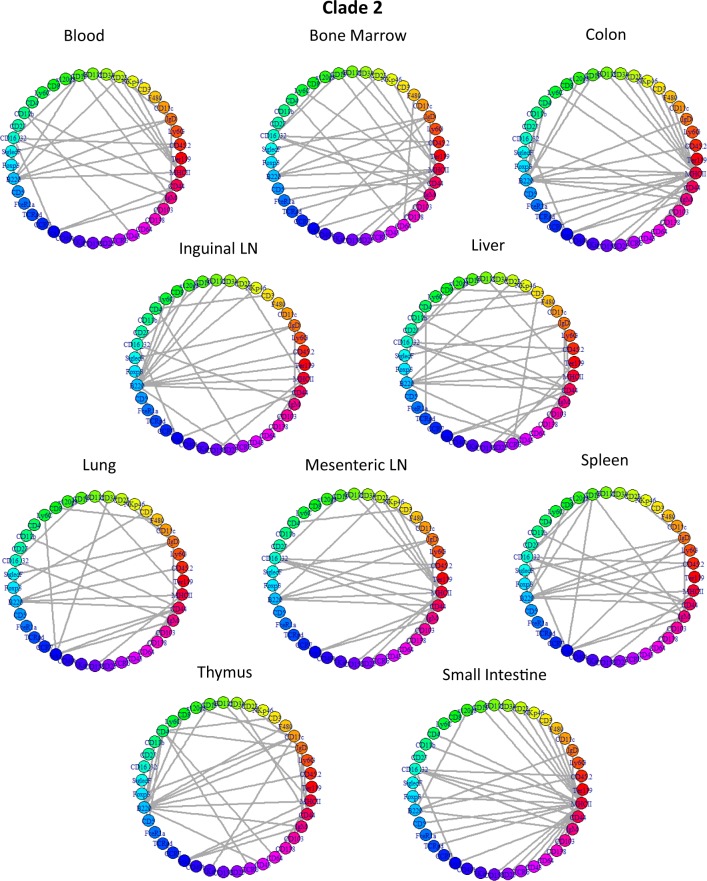
Network structures of Clade 2: B cells.In each network figure, the markers are denoted by nodes of different colors. These networks show the top edges that define the network structures for subpopulations in clade 2. The subpopulation network structures for each subpopulation in clade 2 show that certain markers, such as B220 and MHCII, are hubs across most, if not all, networks in this clade. This hub combination is consistent and unique to clade 2 (see Fig 18).